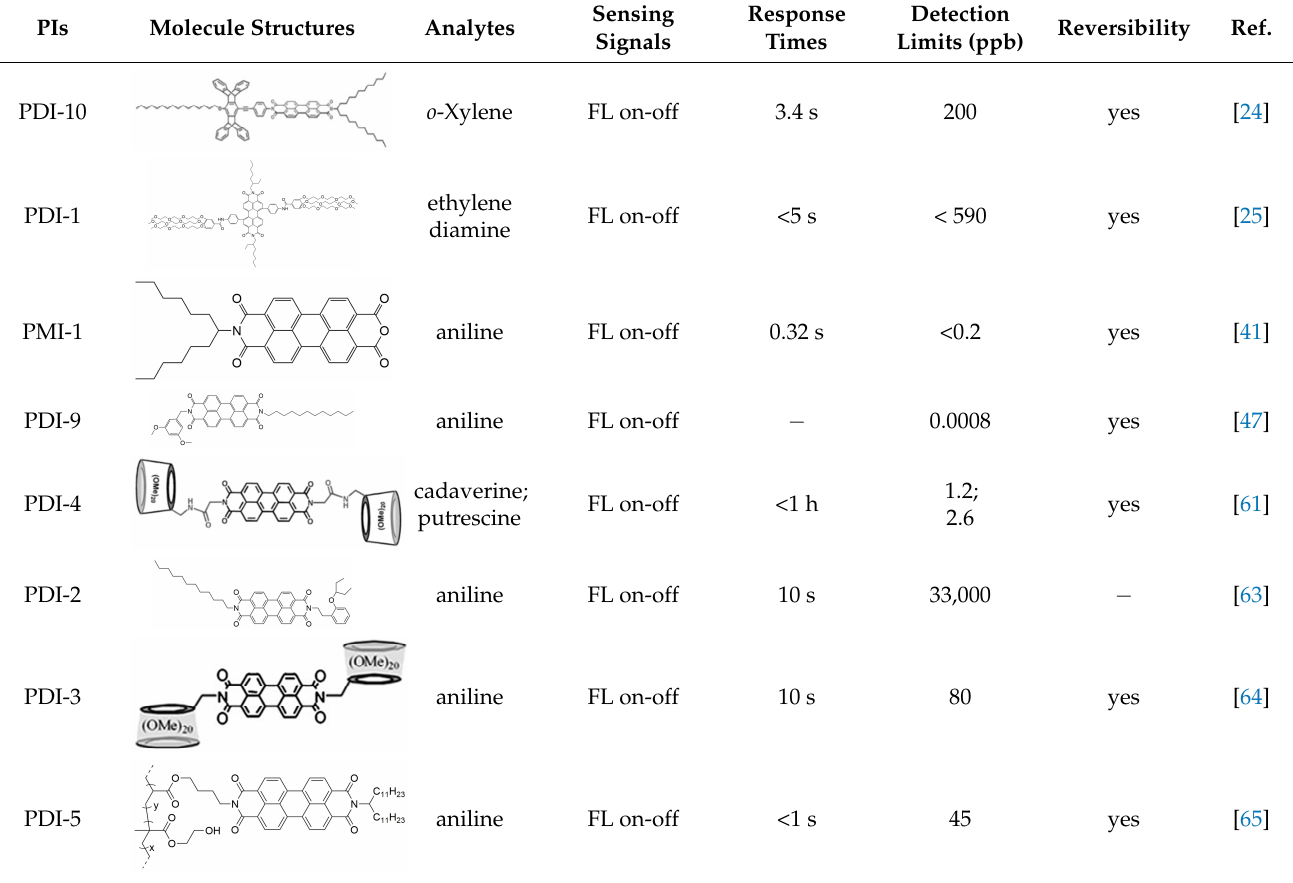
Table 2. Comparison of PIs based optical chemosensors for different vapor analytes. PIs Molecule Structures Analytes